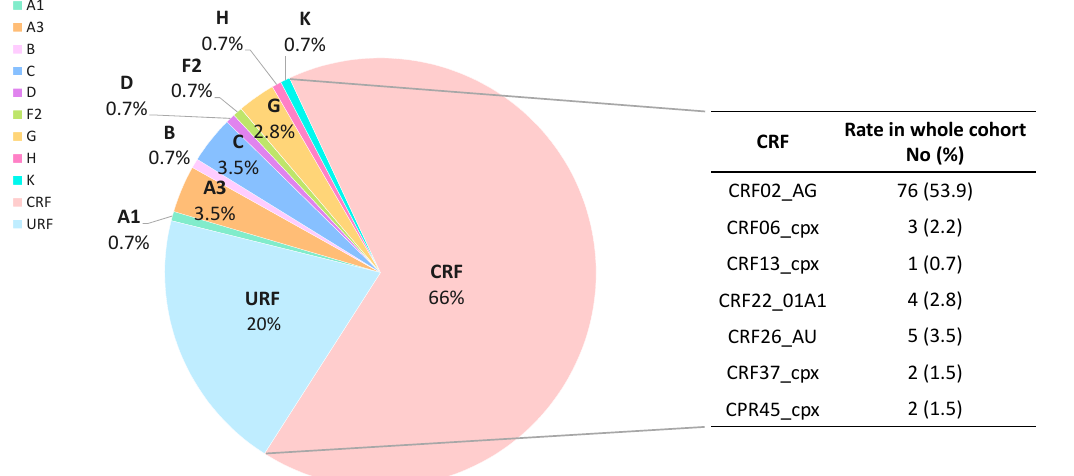
Figure 7. HIV-1 variants in Equatorial Guinea during 2019–2020. HIV-1 variants characterized in 141 infected subjects with available pol sequences (131PR/121RT/97IN) from samples collected during 2019–2020 in Equatorial Guinea. No, number; CRF, circulating recombinant forms; URF, unique recombinant forms.